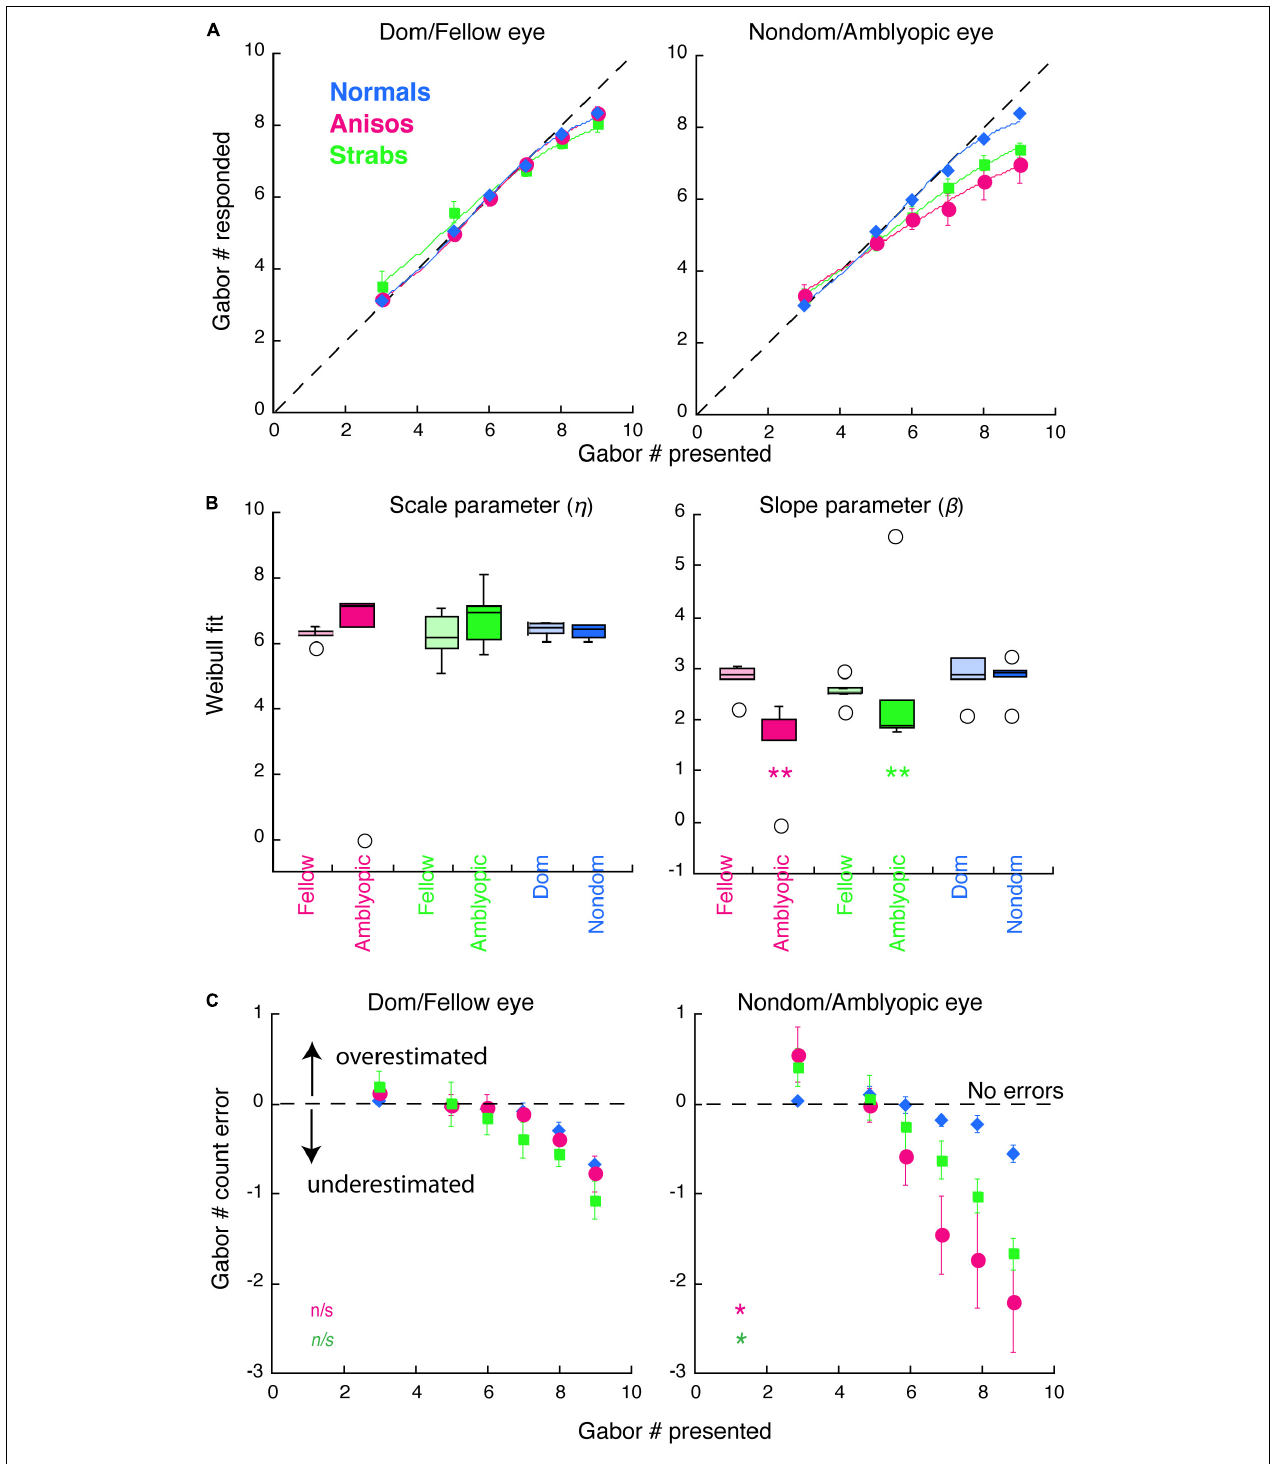
FIGURE 2 | Counting performance in anisometropic and strabismic amblyopes and normal-vision observers when visual features were presented to the same eye within a block in Experiment 1. (A) Group mean of counting performance, in which the subjective estimates of the number are plotted as a function of the number of Gabor patches present. Colors denote the group. Error bars denote SEM. The dashed lines indicate 1:1 ratio between reported and displayed number of Gabors, representing correct estimates. Data below the dashed line indicate underestimates of the number of Gabors. Solid curves are the average model fits of Weibull function. (B) Comparison of the model fit results from individual participants with scale ( η ) and slope ( β ) parameters. (C) Group mean of counting errors from (A) . *, and ** denotes p < 0.025 (significance level by Bonferroni correction) and p < 0.01, respectively.